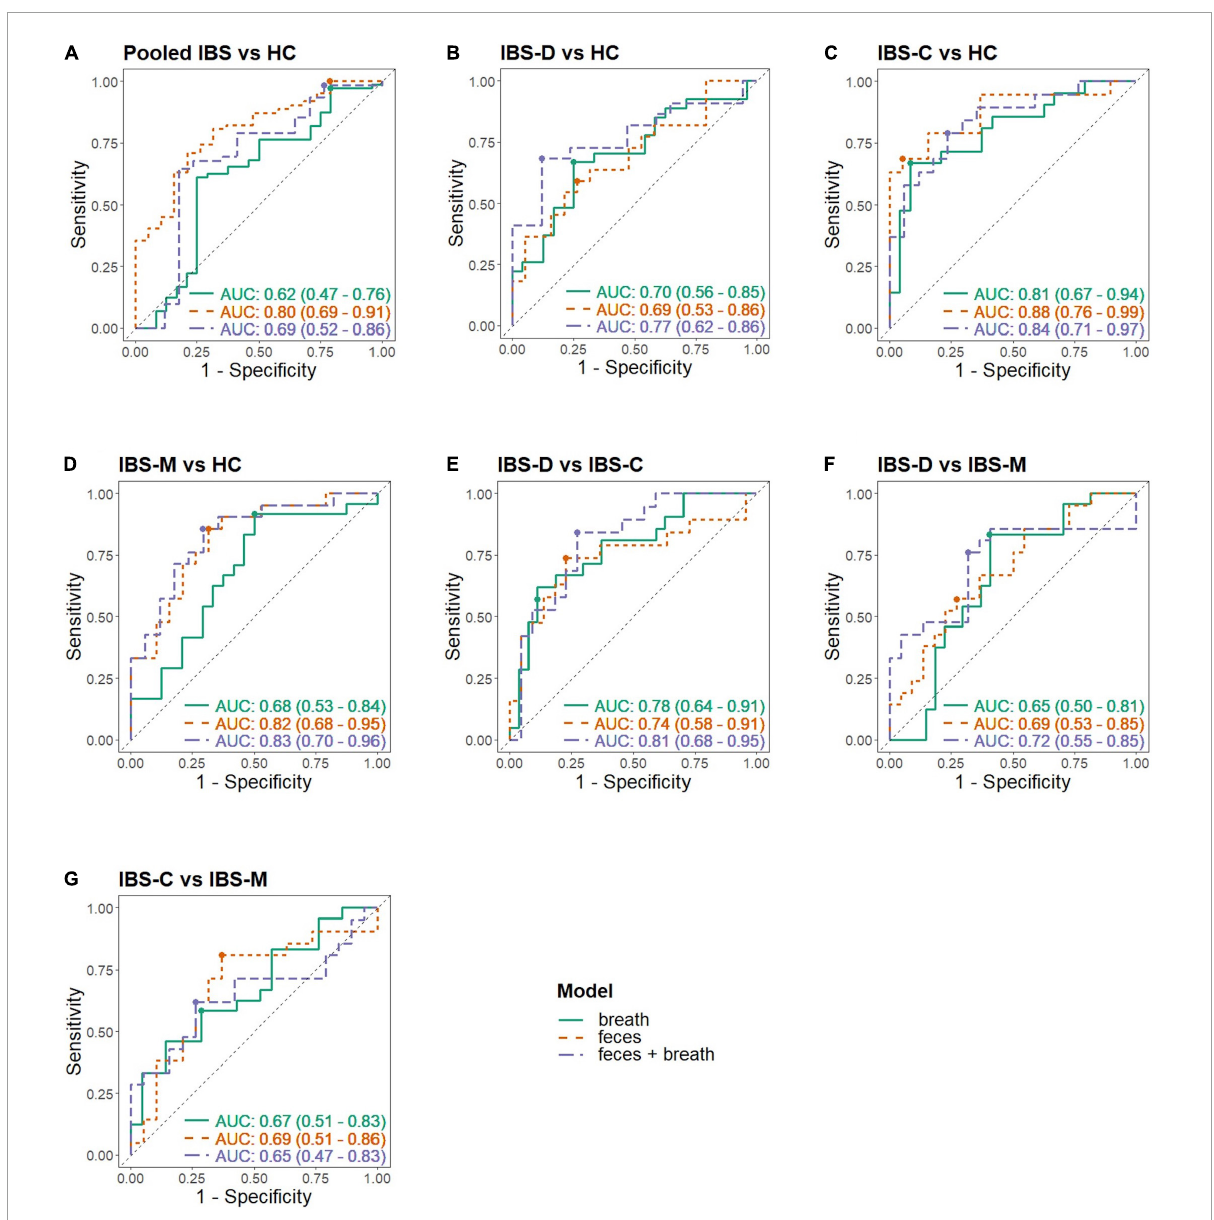
FIGURE3 Receiver operating characteristic (ROC) curves in different matrices. Each panel shows the ROC curve of the breath, fecal, and combined model; (A) Pooled IBS patients vs. HC, (B) IBS-D vs. HC, (C) IBS-C vs. HC, (D) IBS-M vs. HC, (E) IBS-D vs. IBS-C, (F) IBS-D vs. IBS-M, (G) IBS-C vs. IBS-M; -C, constipation; -D, diarrhea; HC, healthy control; IBS, irritable bowel syndrome; -M,